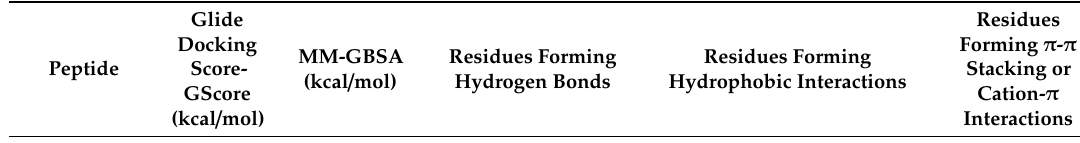
Table 1. Interactions of the best binding pose of LVVYPWTQRF, LVVYPWTRRF, YPWTQRF, and YPWTRRF peptides with angiotensin-I converting enzyme